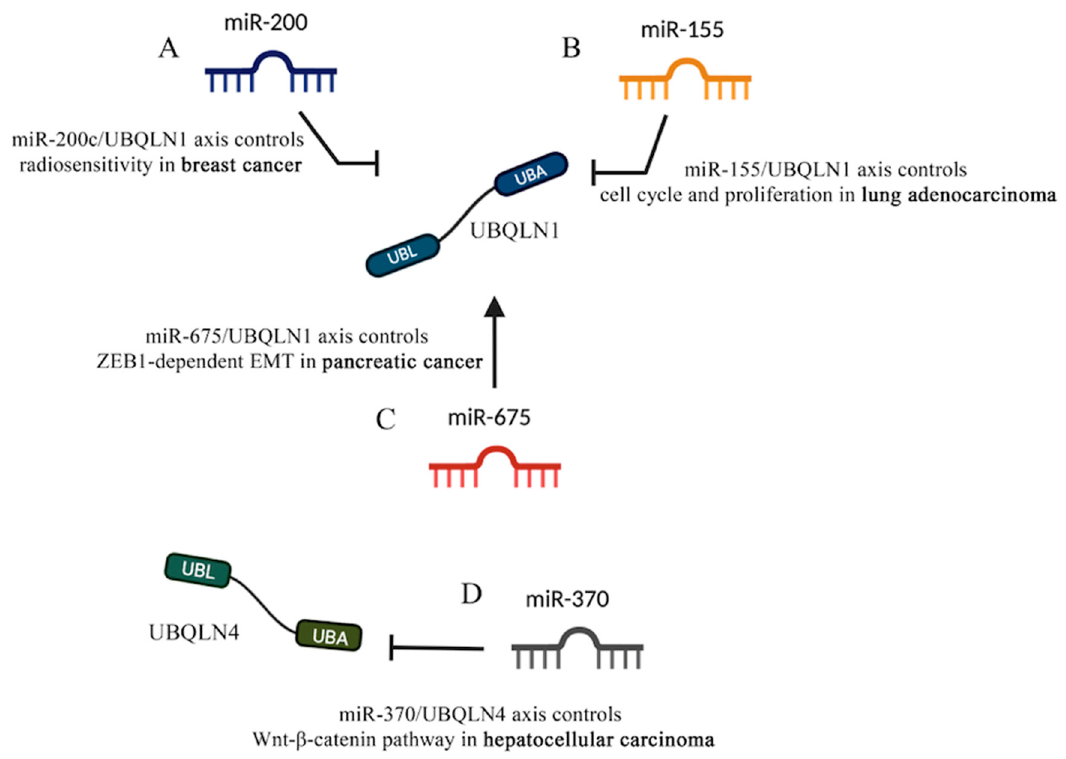
Figure 7. UBQLNs and miRNAs networking in cancers. Different kinds of miRNAs affect UBQLN’s functions that are relevant to cancer. ( A ) miR-200 and ( B ) miR-155 negatively control UBQLN1 functions in breast cancer and lung adenocarcinoma, respectively. ( C ) miR-675 positively controls UBQLN1 in pancreatic cancer. ( D ) The negative control of UBQLN4 by miR-370 in hepatocellular carcinoma is shown.